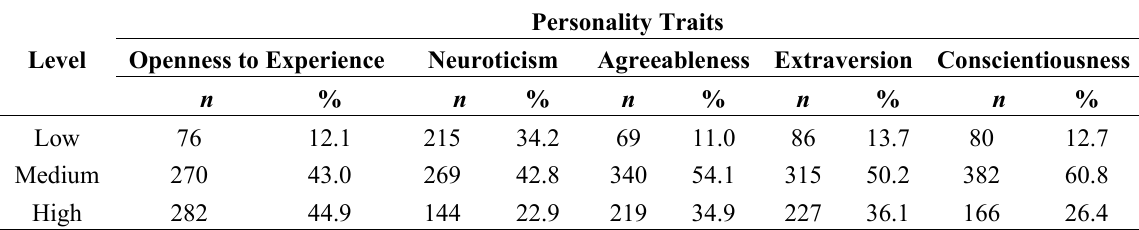
Table 3. Personality traits of respondents according to NEO-FFI.